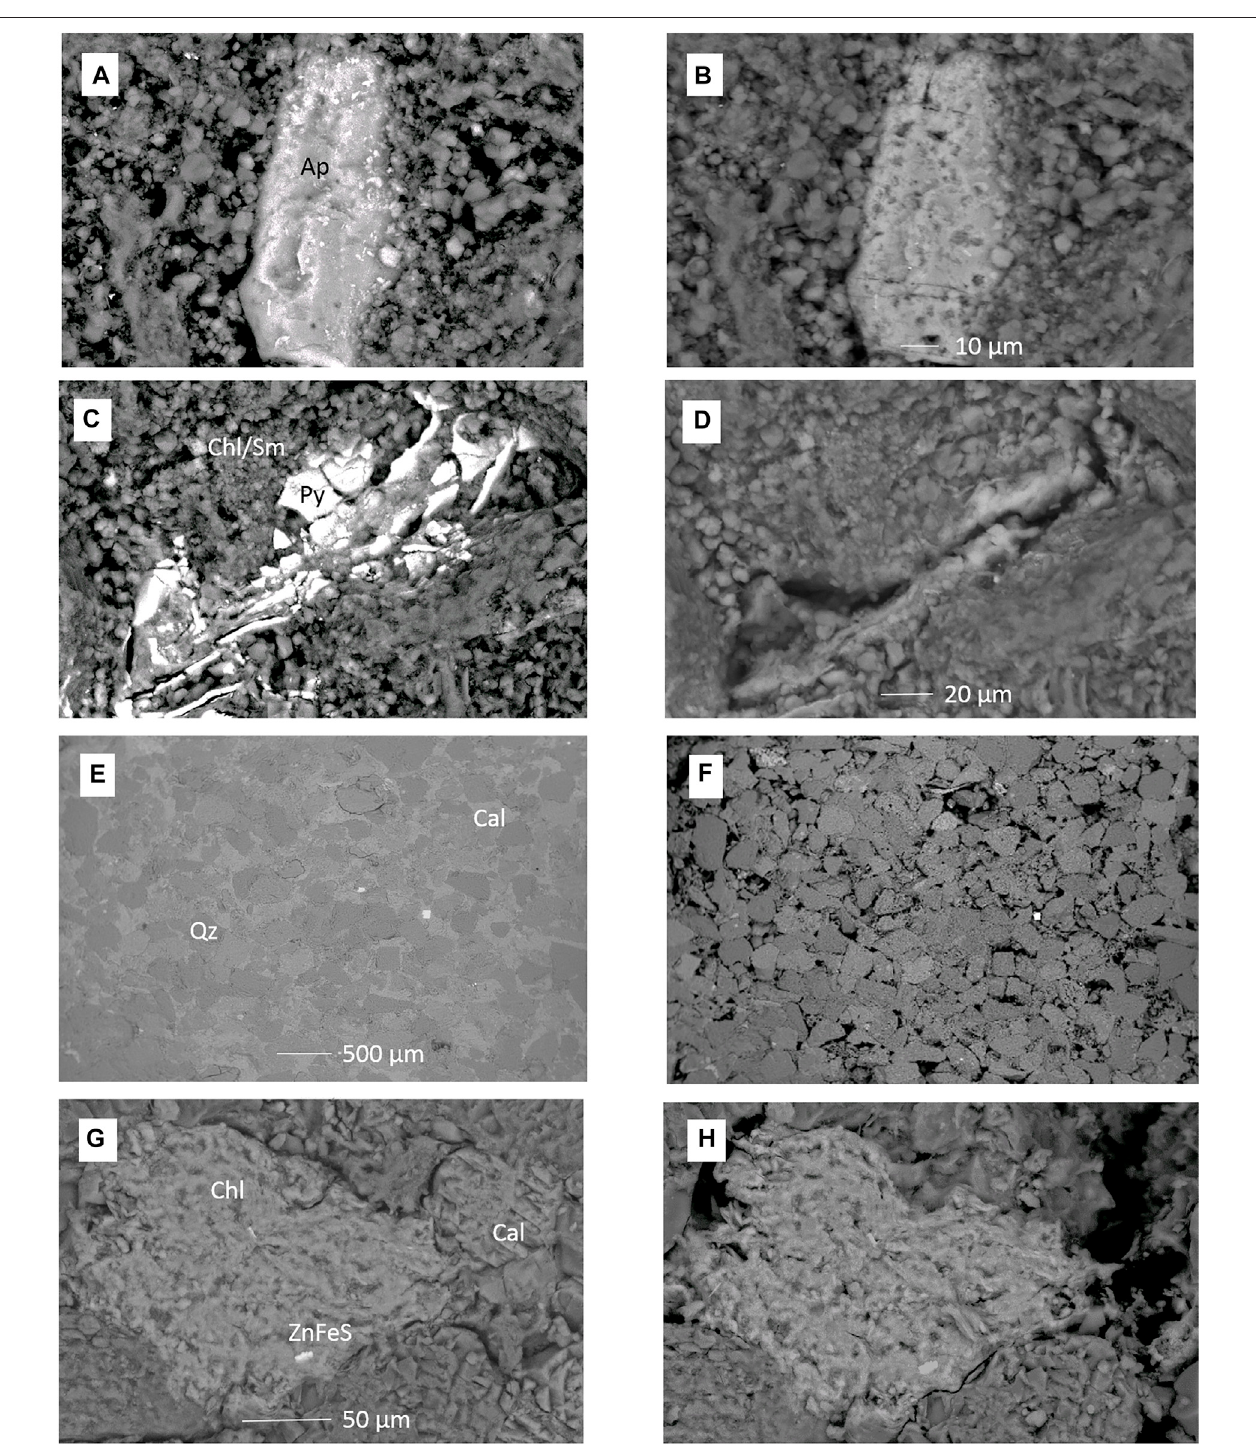
FIGURE 6 | SEM images of (A – D) feldspar-rich sandstone 1043.70 m before and after reaction with CO 2 SO 2 NO and formation water. (A) Apatite before reaction and (B) apatitecorrodedafterreaction. (C) Pyritecementinclaymatrixbeforereactionand (D) pyritedissolvedordislodgedwithclay fi nesfromthesurfaceafterreaction. (E – H) Calcite cemented sandstone 1056.03 m before and after reaction with pure CO 2 and formation water. (E) Calcite cemented framework grains and (F) after reaction with calcite cements dissolved. (G) Chlorite, calcite cements, and ZnFeS cement. (H) After reaction with calcite dissolved, chlorite slightly corroded and ZnFeS corroded. Ap, apatite; Chl/Sm, mixed chlorite and smectite; Py, pyrite cement; Qz, quartz; Cal = calcite cement.